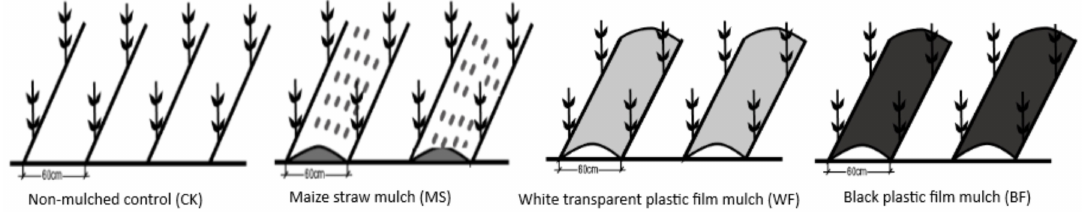
Figure 1. Field planting pattern pictures of di ff erent